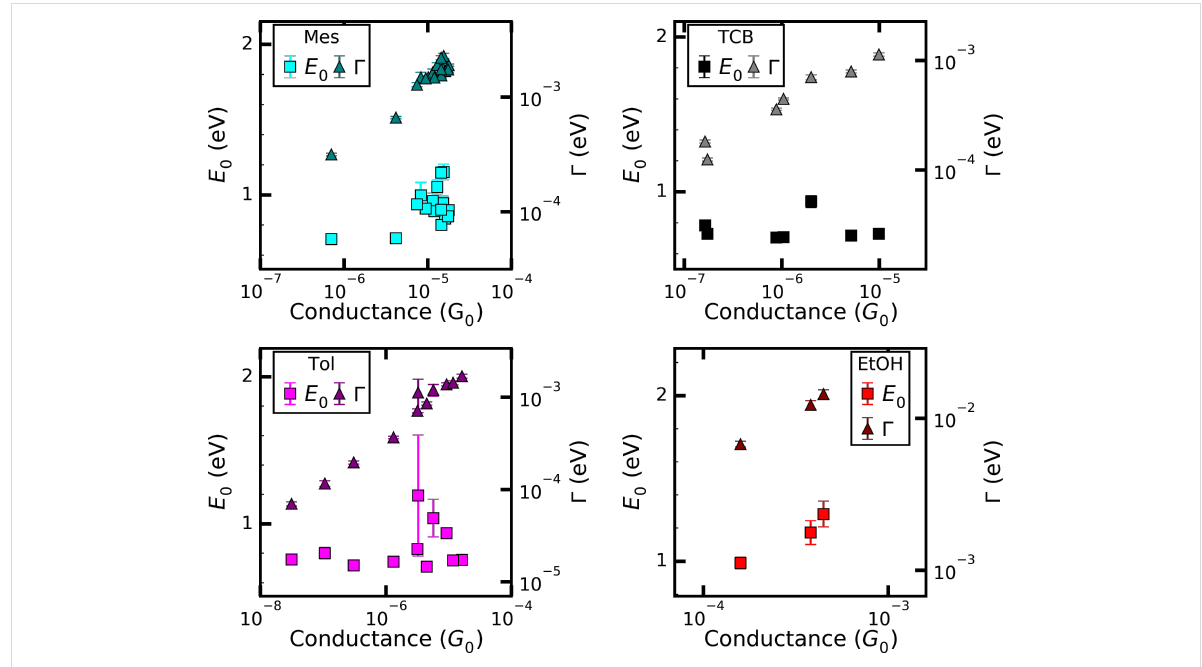
Figure 5: Fitting results using the SLM (Equation 3 and Equation 4). The error bars denote the numerical error of the least-squares fitting of the indi- vidual curves.